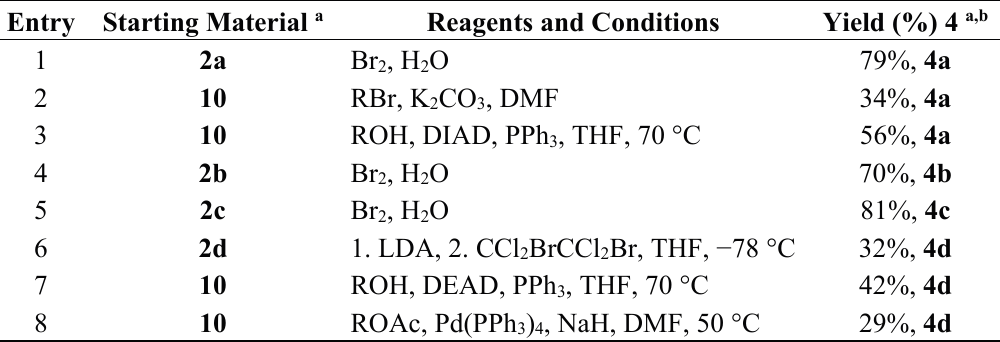
Table 2. Synthesis of 8-bromopurines 4